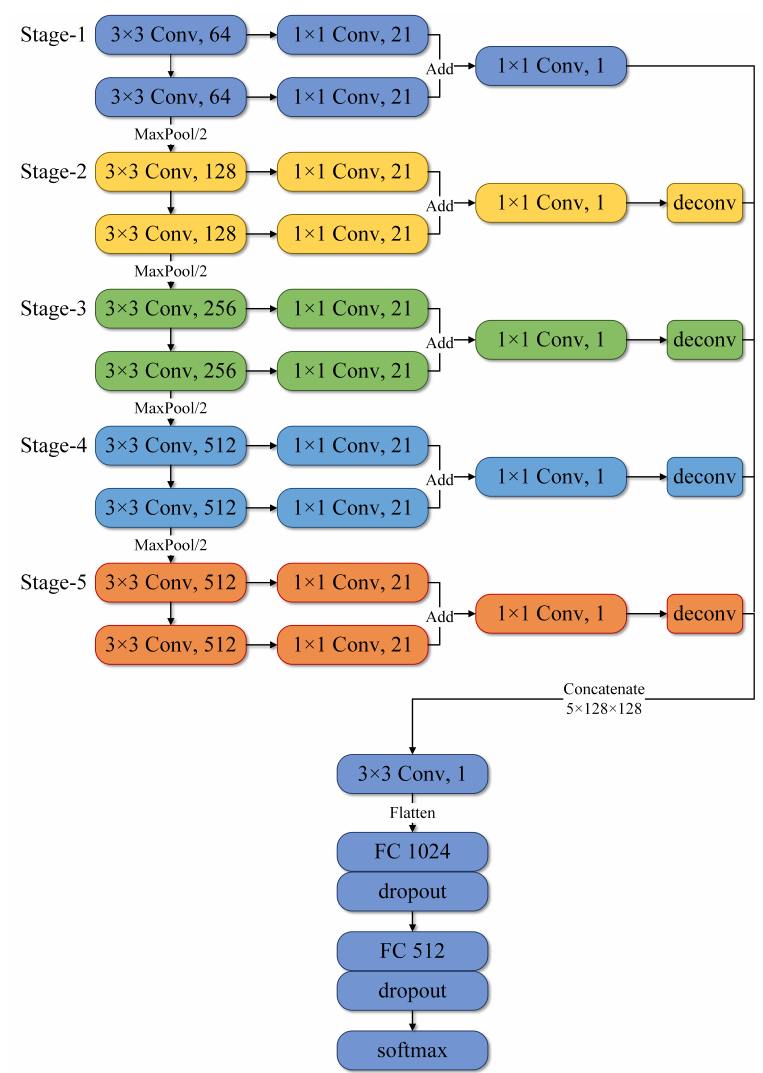
Figure 4. The proposed MLF-CNN